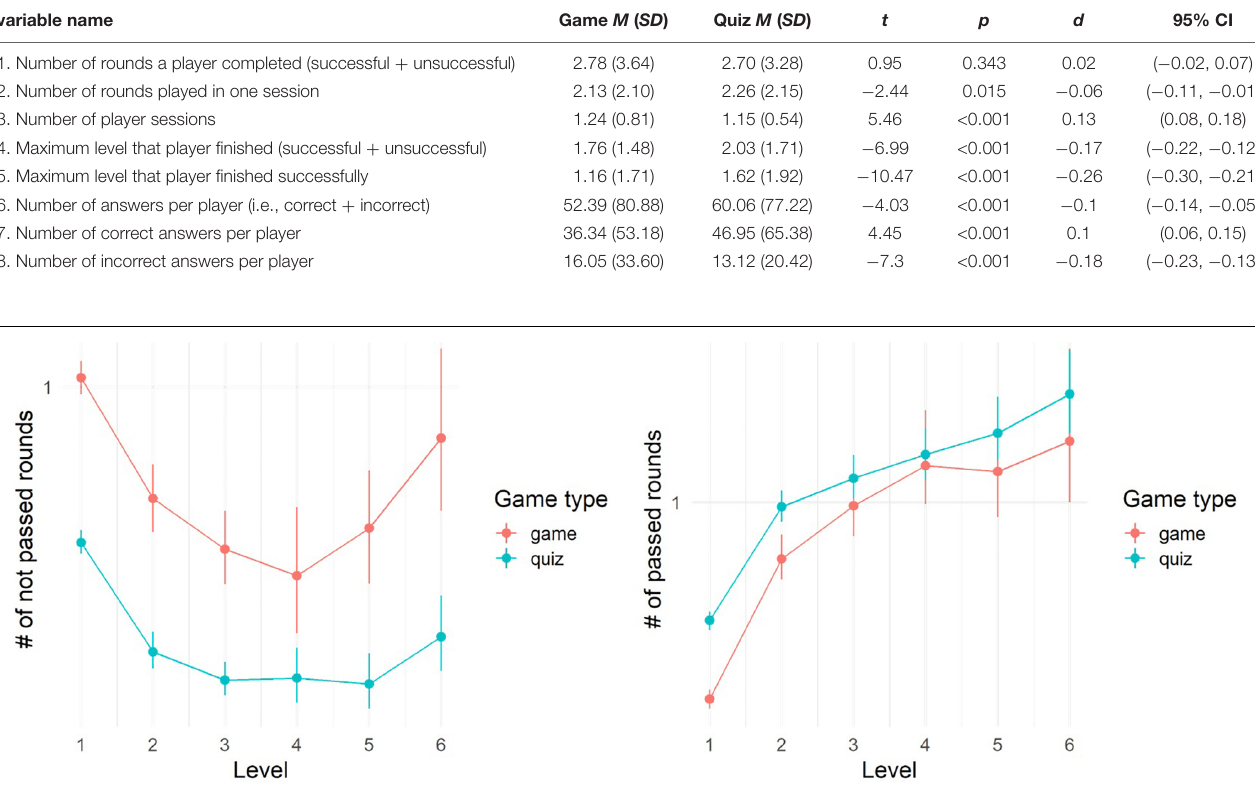
Frontiers in Psychology |